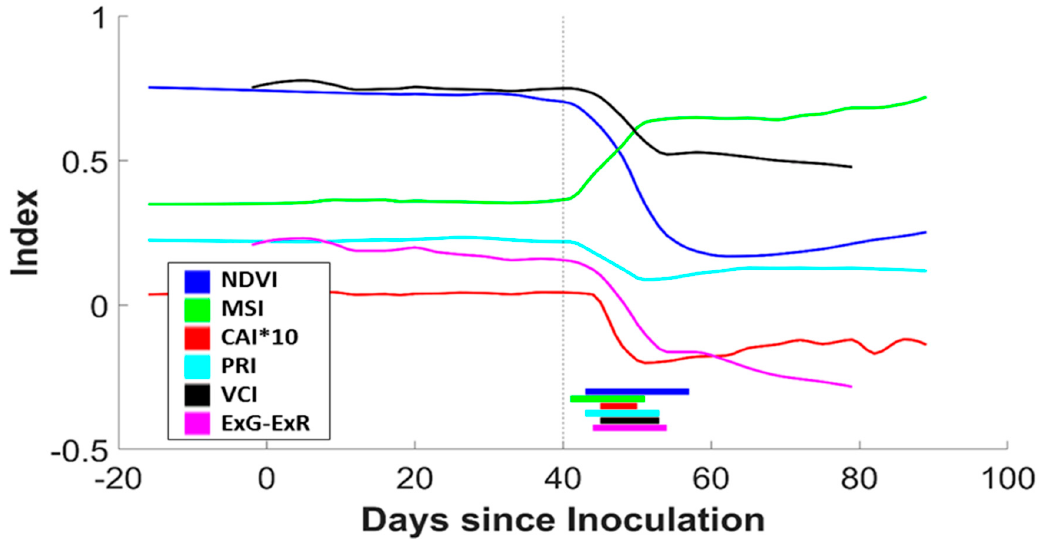
Figure 8. Smoothed VI curves for plant #7 ( C. huliohia inoculation). First laboratory observation of wilting indicated by dashed vertical line. Colored horizontal bars represent onset and duration of active wilting phase, based on change detection analysis of the VI curves as illustrated in Figure 3. VI curves for all plants included in the laboratory trials are shown in Supplementary Figures S1 and S2.